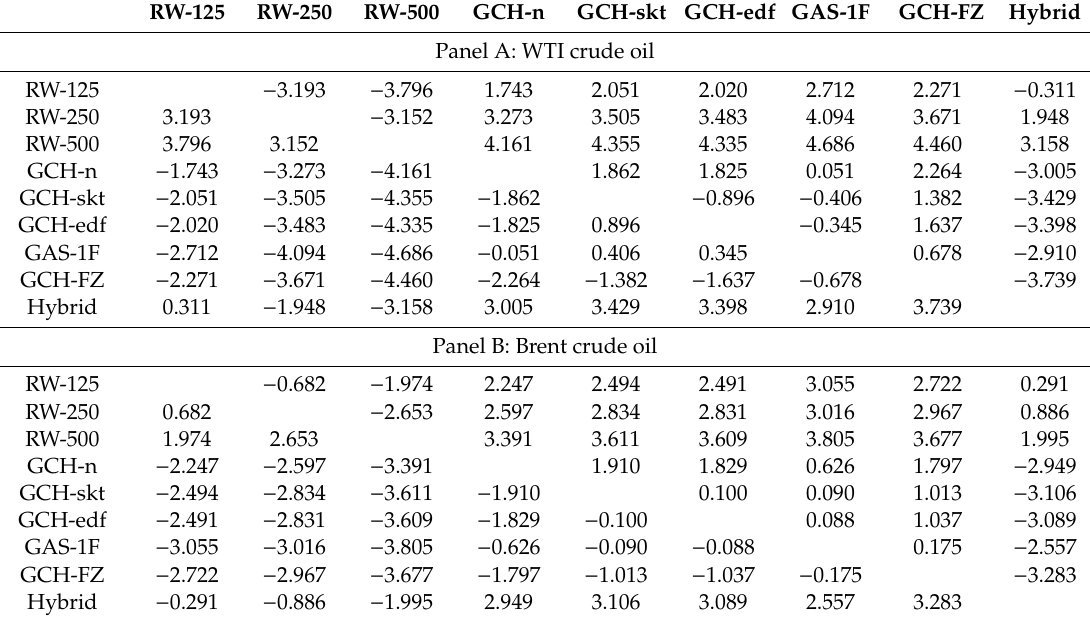
Table 5. The Diebold − Mariano t -statistics of the average out-of-sample loss di ff erences ( α =